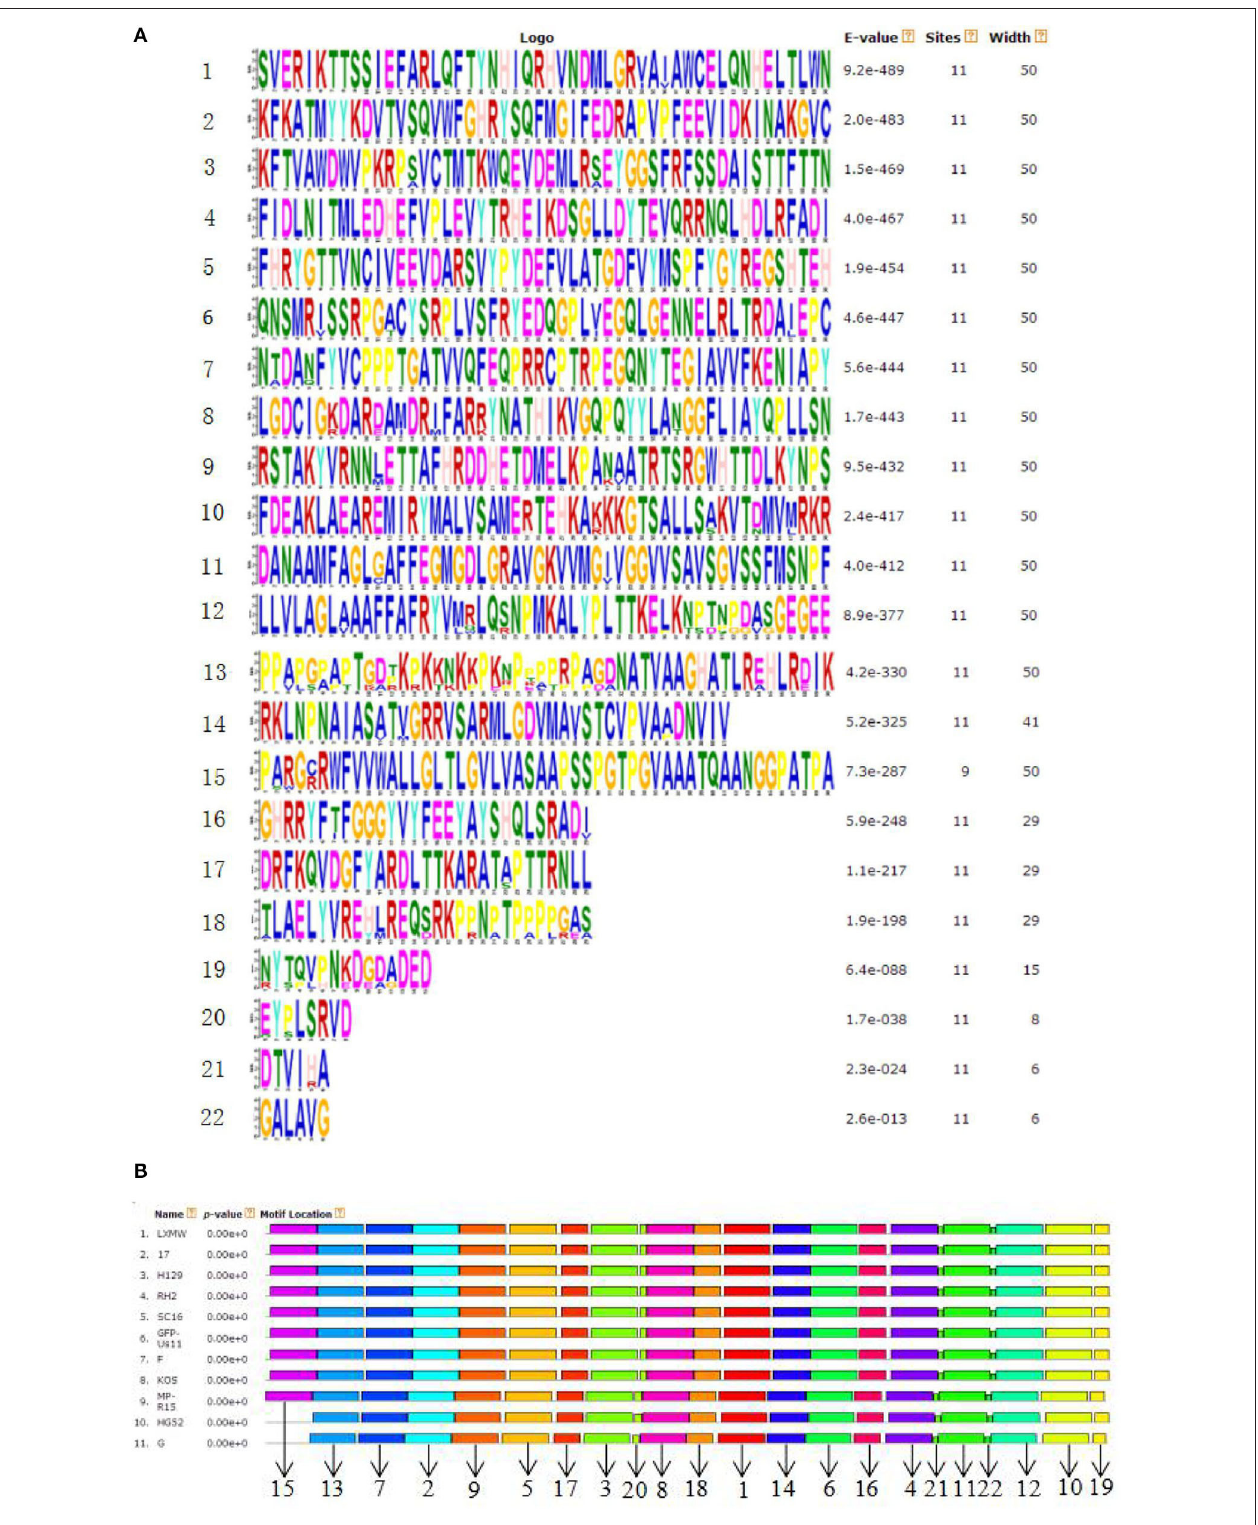
FIGURE 3 | (A) The predicted consensus sequences of the 22 motifs from the gBs of 11 HSV strains. (B) The location of the 22 new gB motifs (1–21, 23) predicted in (A) .